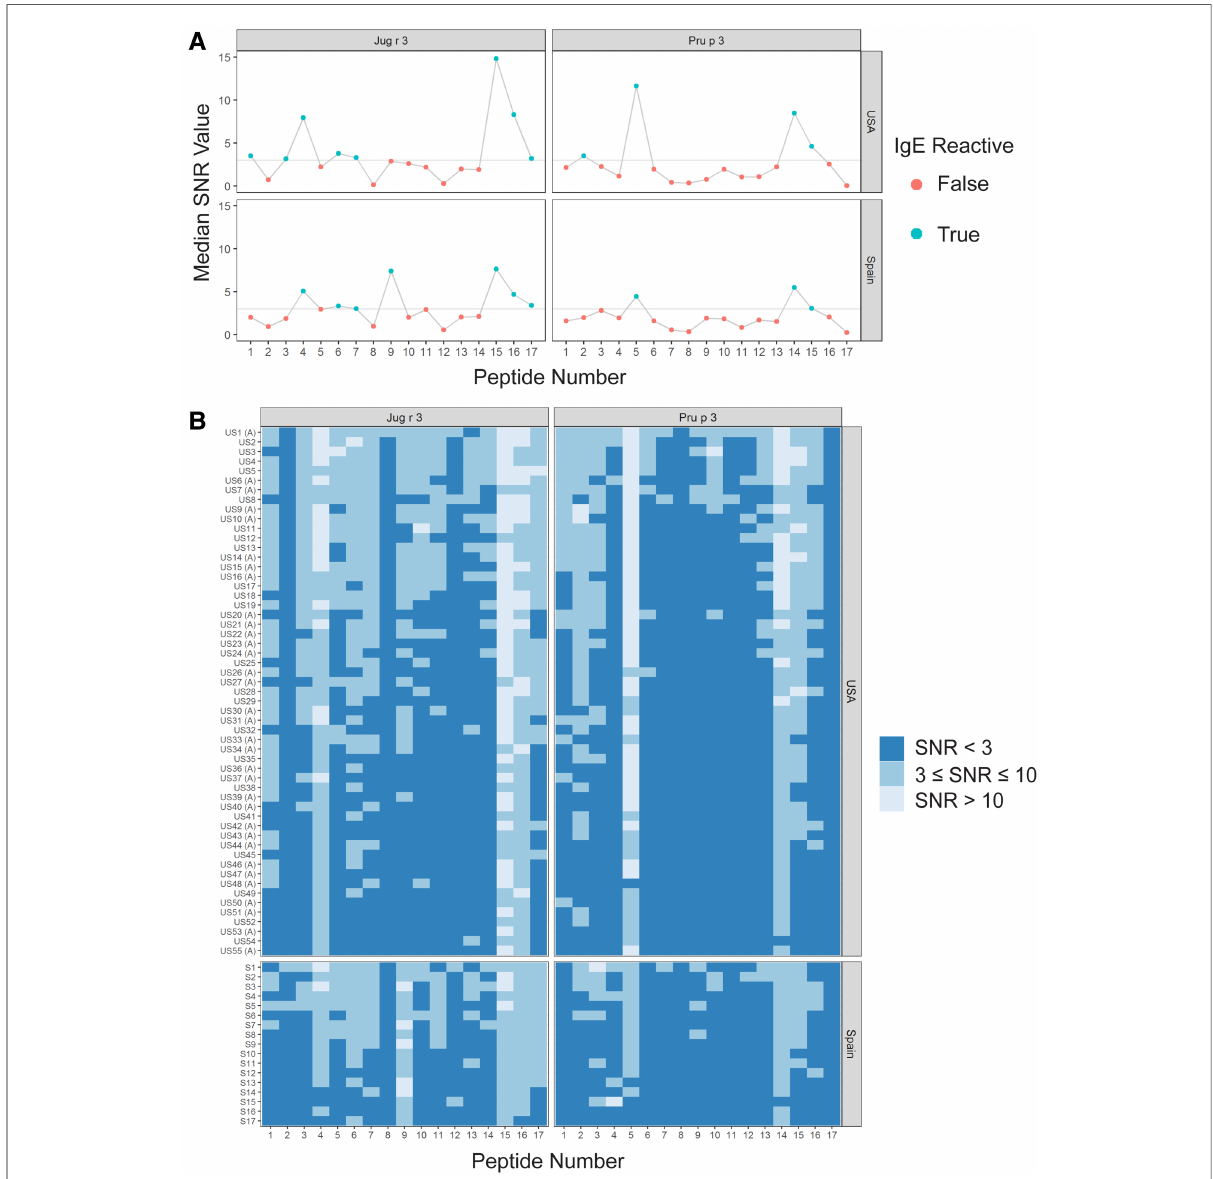
FIGURE 2 IgE binding to Jug r 3 and Pru p 3 by peptide and region (USA vs. Spain). ( A ) Dot plots representing the median SNR values for each peptide. Dots are colored blue (True) if the peptide is a major IgE reactive peptide ( ≥ 50% of the subjects have positive IgE binding) and pink (False) otherwise. The horizontal line represents the de fi nition for positive binding: SNR ≥ 3. ( B ) Heat maps representing the subject-speci fi c IgE intensities, which are categorized and displayed as follows: SNR<3 (dark blue), SNR ≥ 3 and ≤ 10 (medium blue), SNR>10 (light blue). US samples depicted with ( A ) represent sera samples provided by Aimmune